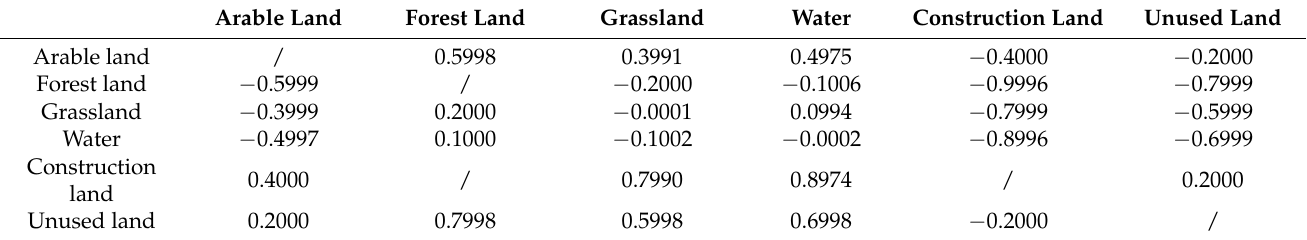
Table 4. Response index (RI) values for the impact of land use conversions on HQ changes from 1980 to 2020 in Wusu,